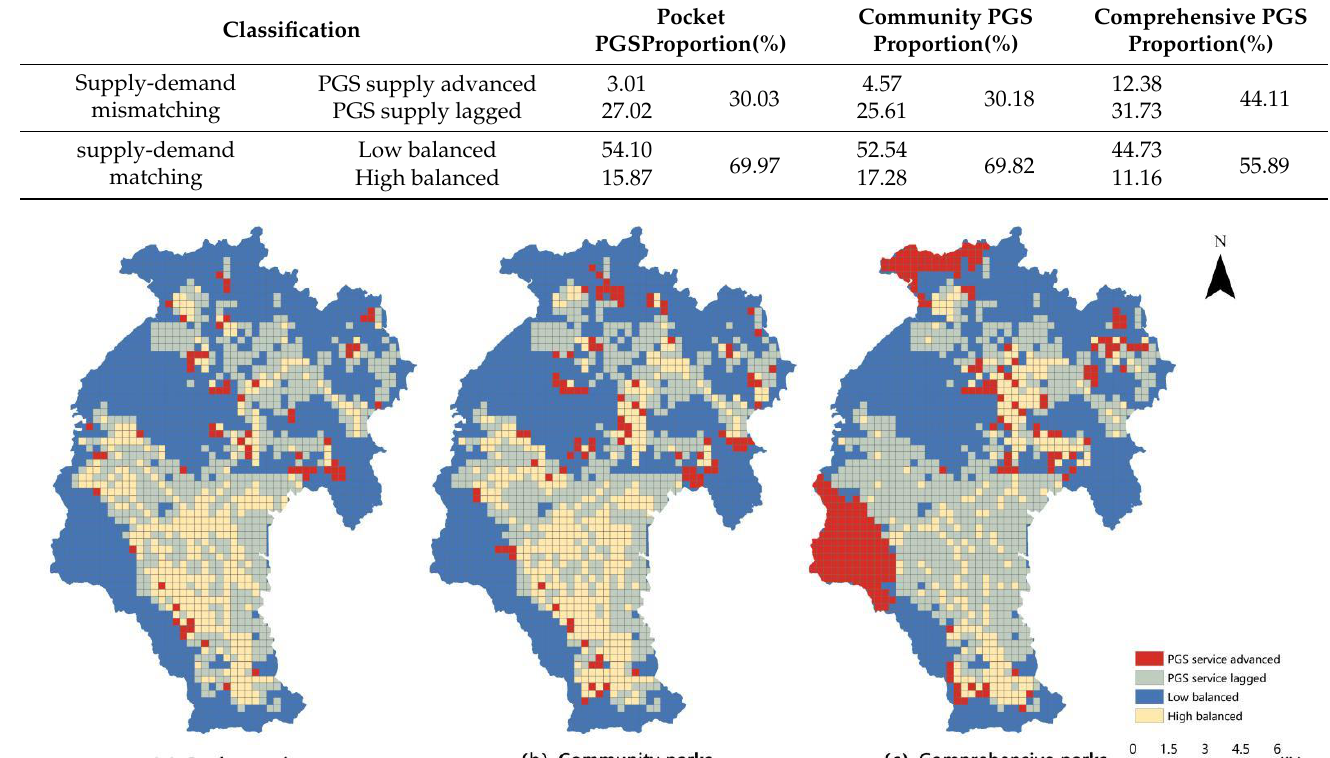
Table 7. Classification and proportion of PGS-SED supply-demand matching.